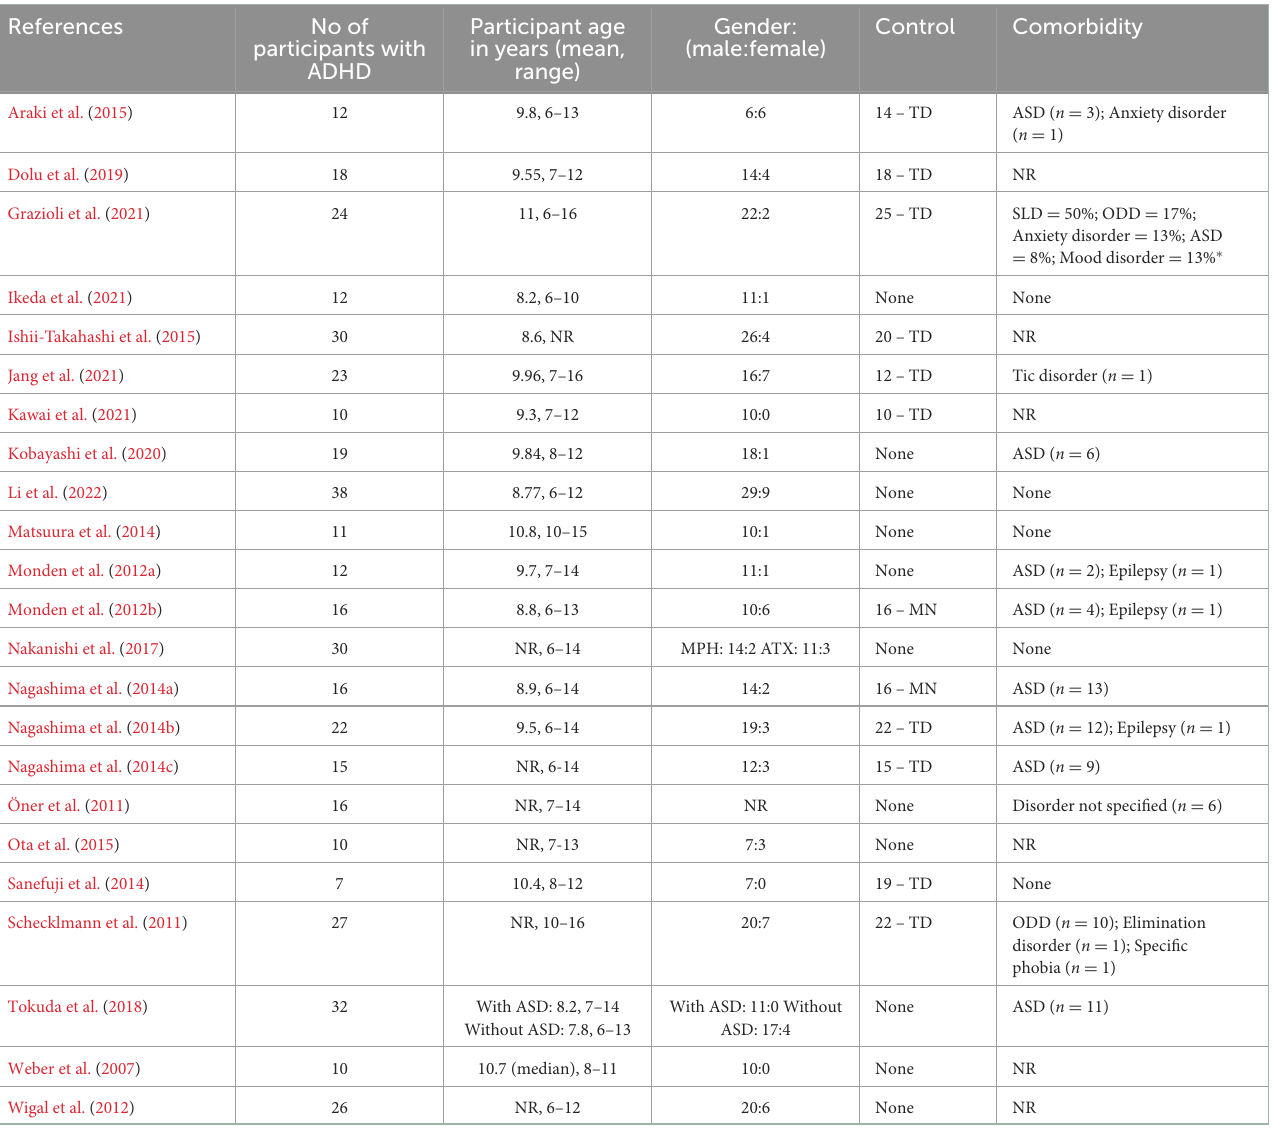
TABLE 1 Participant demographics from retrieved